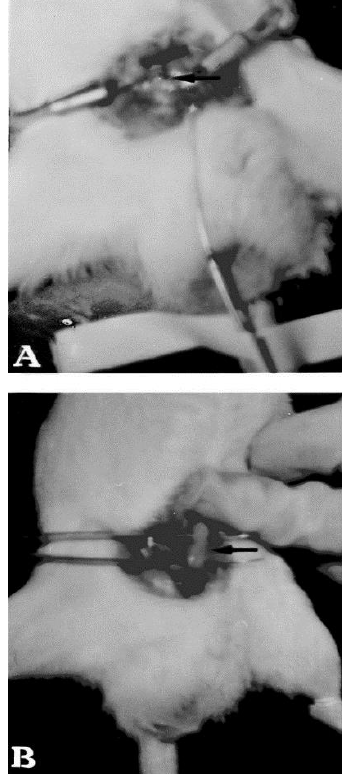
Figure 3. In vivo localization of a liquid suppository in the rectum. Liquid suppository made up of P407/P188/polycarbophil/acetaminophen (15/19/0.8/2.5% w / v ) with 0.1% blue lake was introduced into the rectum of a rat. At 5 min ( A ) and 6 h ( B ) after administration, the rectum was sectioned. Reprinted from [79] with permission from Elsevier, 1998.